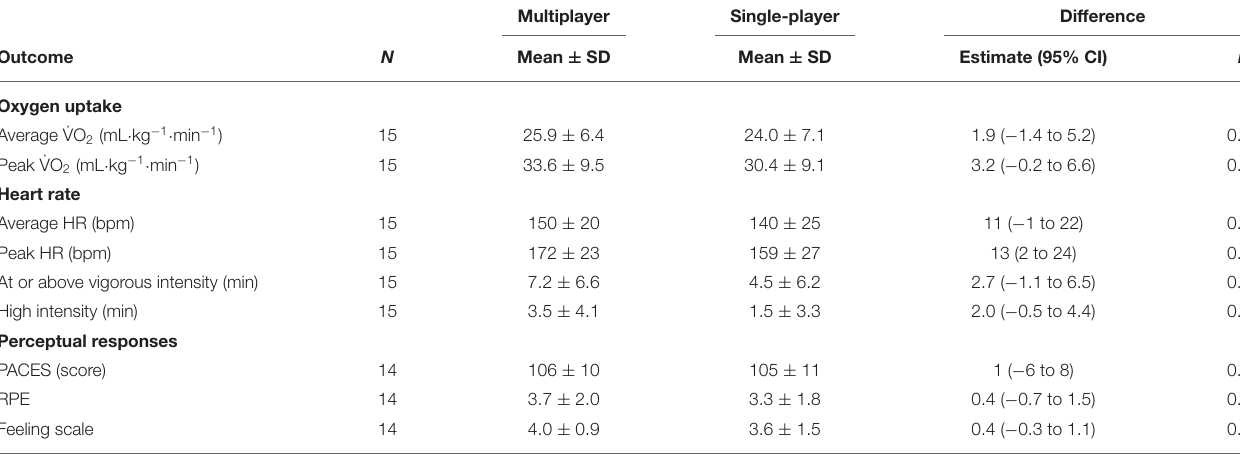
TABLE 2 | Physiological and perceptual responses to single- and multiplayer